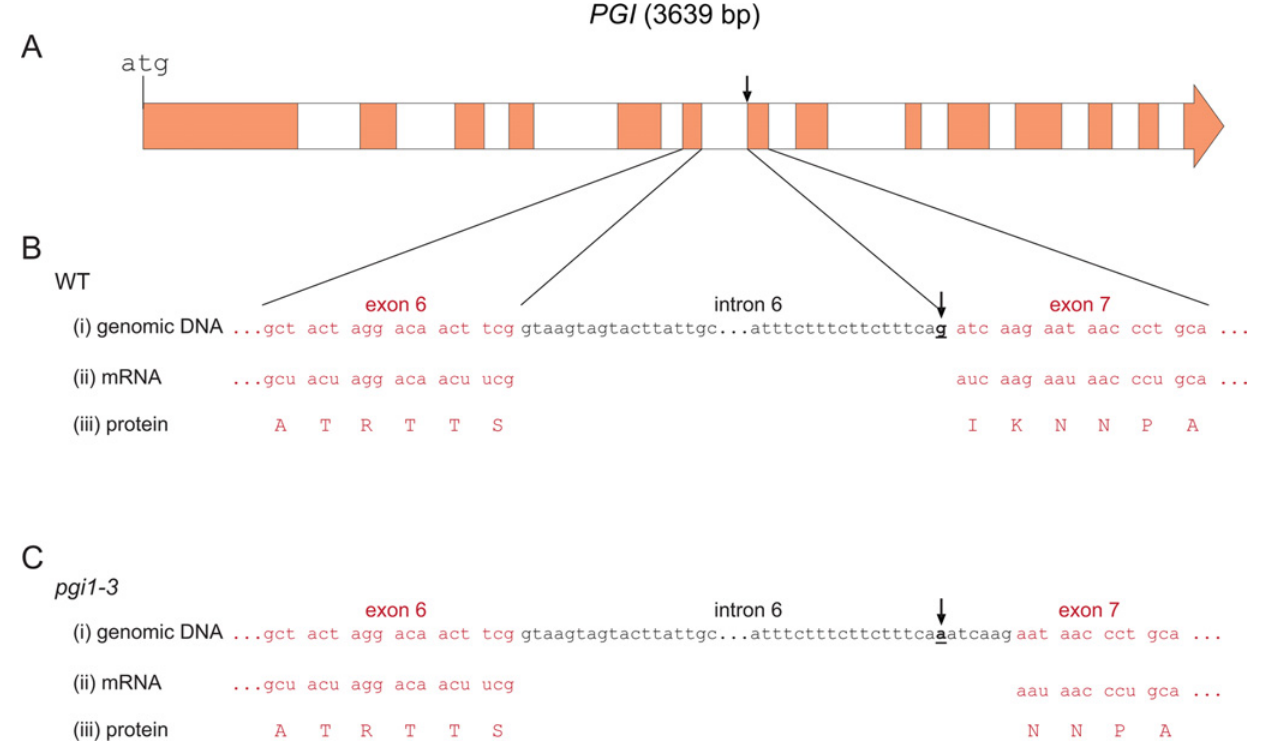
Fig 1. Molecular characterization of pgi1 – 3 . (A) Genomic PGI1 structure. In “ B ” and “ C ” , comparisons between the genomic DNA (i), the mRNA (ii), and the derived protein sequence (iii) of WT and the N92274 ( pgi1 – 3 ) mutant. In “ i ” only the splicing sequences between the exon 6 and intron 6, and between the intron 6 and exon 7 are shown. Arrows indicate the point mutation site in pgi1 – 3 . Exon sequences and their respective deduced amino acidic sequences are highlighted in red